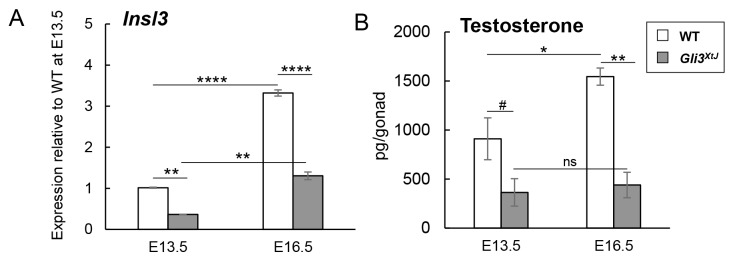
Gli3XtJ mutant testes produce insufficient hormones.A) RT-qPCR comparing expression of Insl3 transcripts in wild type (n = 3) and Gli3XtJ (n = 3) testes at E13.5 and E16.5. Results are reported relative to E13.5 wild type testis. B) Testicular testosterone levels as measured by ELISA at E13.5 and E16.5 (WT n = 6; Gli3XtJ n = 4). Results are represented as mean ± SEM. (A, B) One-way ANOVA followed by post-hoc Tukey’s test, #: p<0.1, *: p<0.05, **: p<0.01, ****: p<0.0001, ns: non-significant.